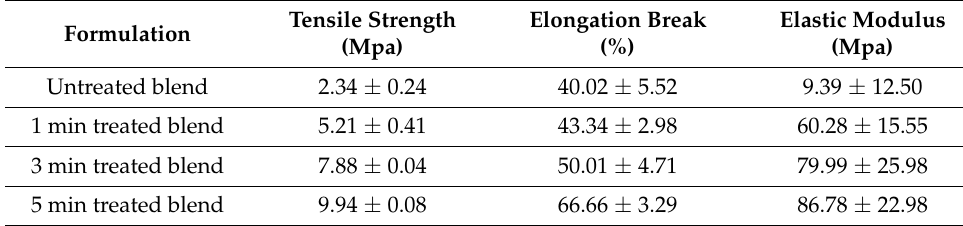
Table 3. Mechanical properties of various film formulations.